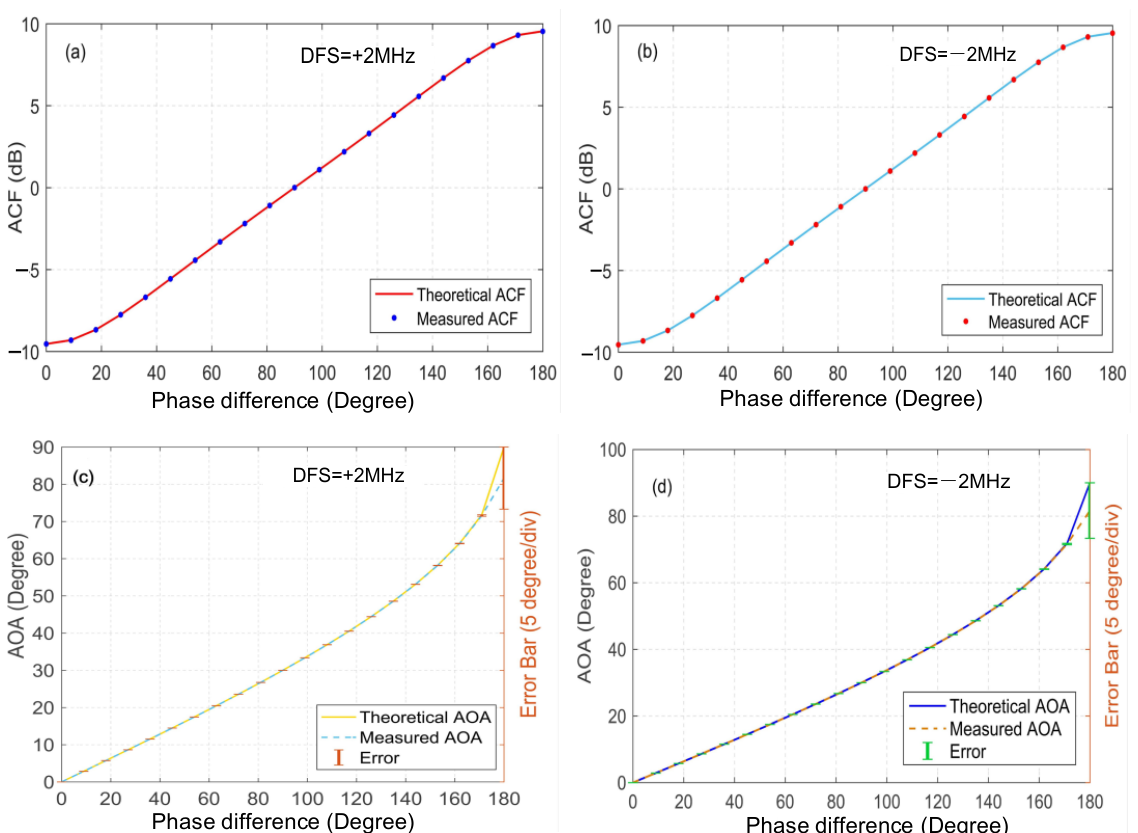
Figure 6. Comparison of the calculated value and the simulated value of ACF and AOA at different phase shifts. ( a , c ) for DFS = +2 MHz, ( b , d ) for DFS = − 2. Subsequently, to clearly distinguish the direction of DFS, the signals of two channels are connected to a Dual Port RF Spectrum Analyzer to observe the phase relationship between the two signals as the phase difference in the range of 0 ◦ to 180 ◦ . Here, the phase difference between the echo signals of 0 ◦ , 60 ◦ , 90 ◦ , 120 ◦ , 160 ◦ and 180 ◦ are selected to observe the temporal waveforms when the DFS are +2 MHz and − 2 MHz, as shown